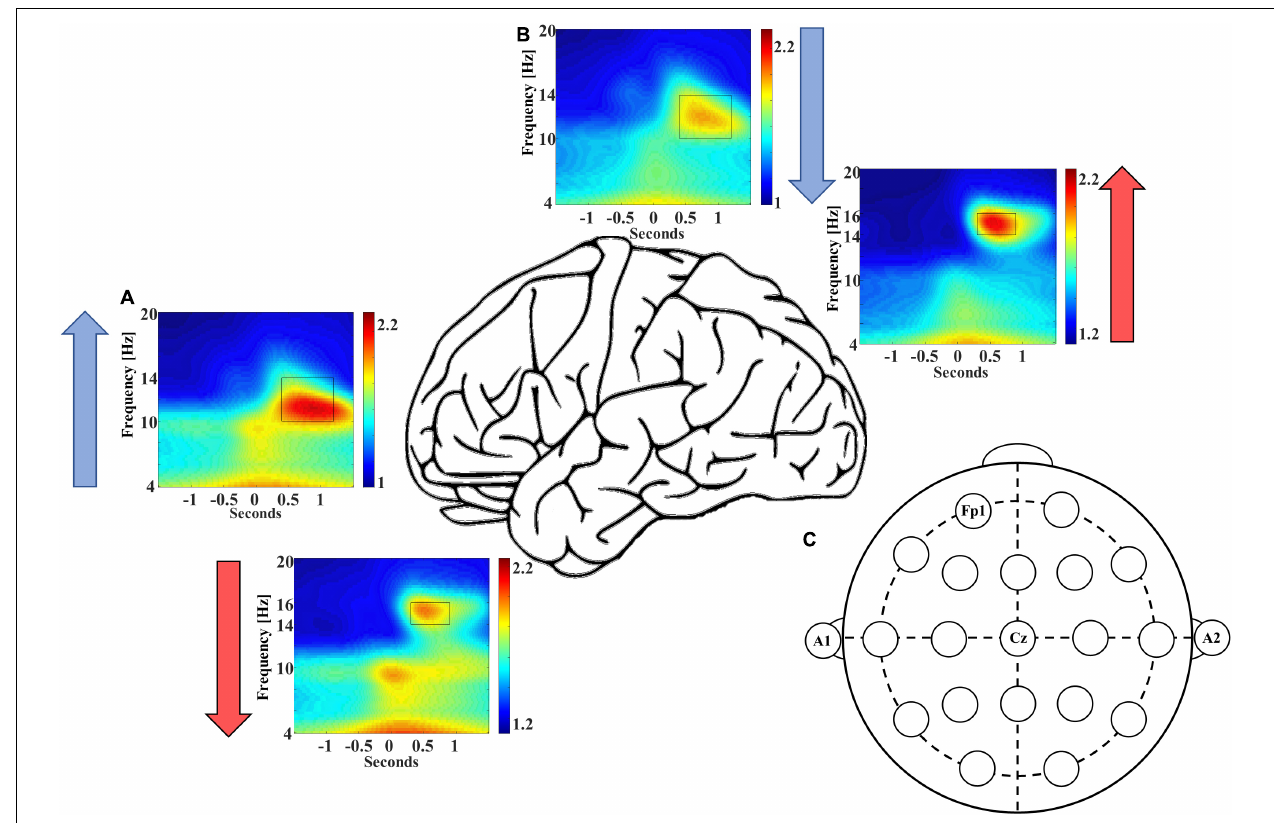
FIGURE 2 | Frontal recording site FP1 demonstrates higher late-fast spindle EEG power (A) , while central recording site Cz demonstrates higher early-fast spindle EEG power (B) . Blue and red arrows indicate the direction of EEG power differential between electrode recording sites. (C) An electrode position diagram is provided for reference to the FP1 and Cz recording site locations [FP1 for panel (A) and Cz for panel (B)